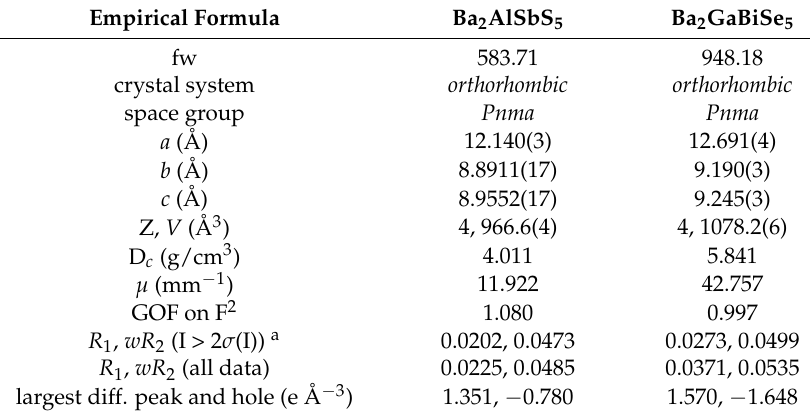
Table 1. Crystal data and structure refinement for the title compounds.